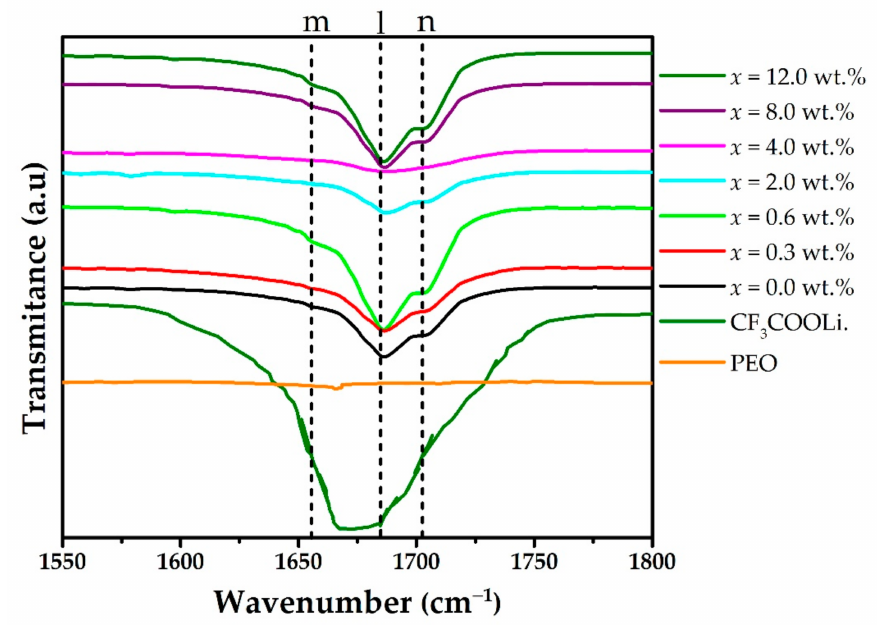
Figure 5. FTIR spectra for PEO, CF 3 COOLi, and different concentrations of MWCNT in the (PEO) 4 CF 3 COOLi electrolyte, for wavenumber ranging from 1550 to 1800 cm − 1 . The dotted vertical lines stand for some wavenumber: m = 1655 cm − 1 , l = 1673 cm − 1 ; n = 1702 cm − 1 .